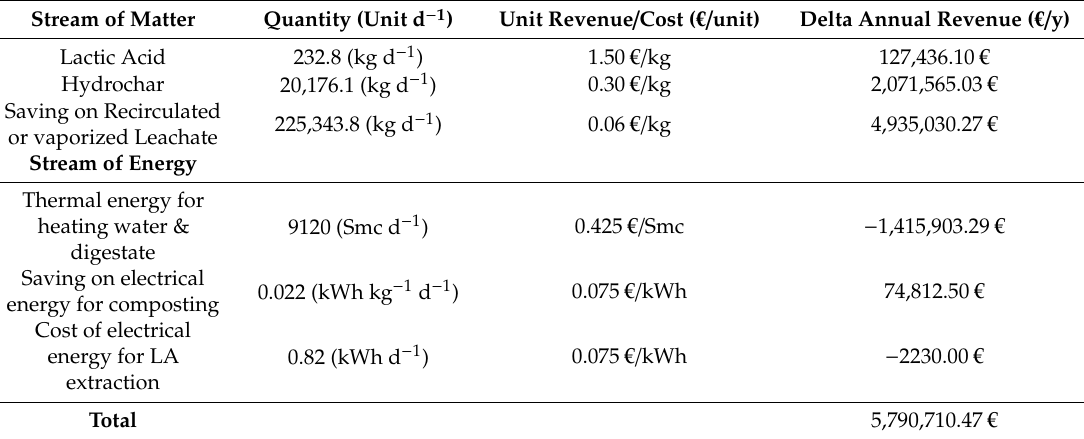
Table 9. Economic flux evaluation with reference to Figure 7